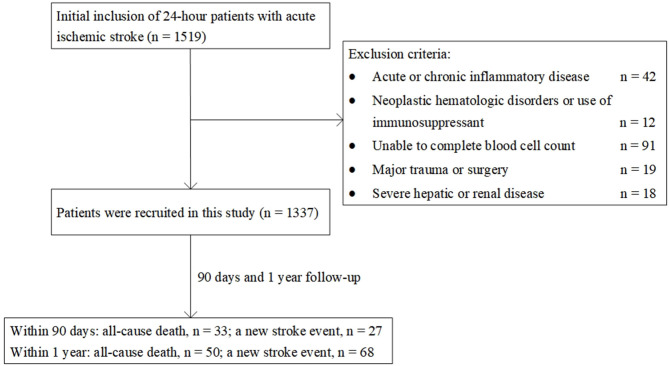
Patient flowchart of the cohort.